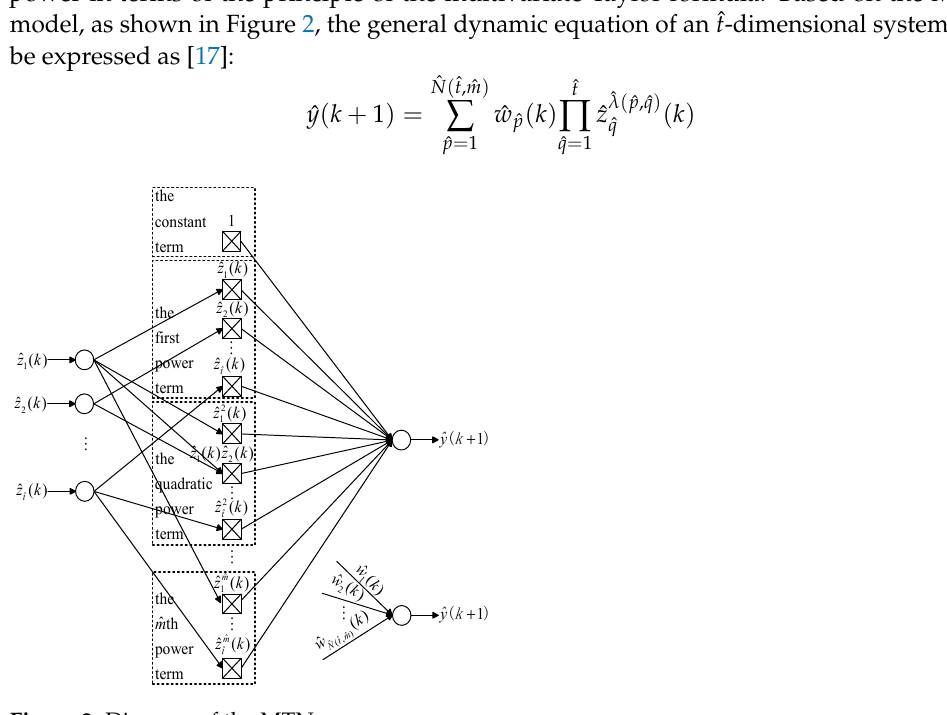
Figure 2. Diagram of the MTN.